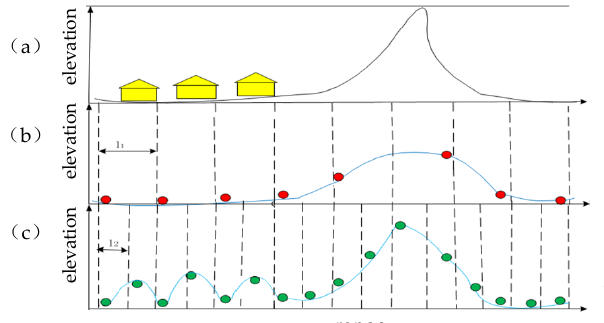
Figure 3. Ground points selection for a steep terrain area with buildings. In part ( a ), buildings and terrain are shown in different colors. In parts ( b ) and ( c ), dashed lines define the grid cells for ground points selection; the red and blue circles represent the lowest points, and the blue lines represent the initial terrain constructed with the lowest points.